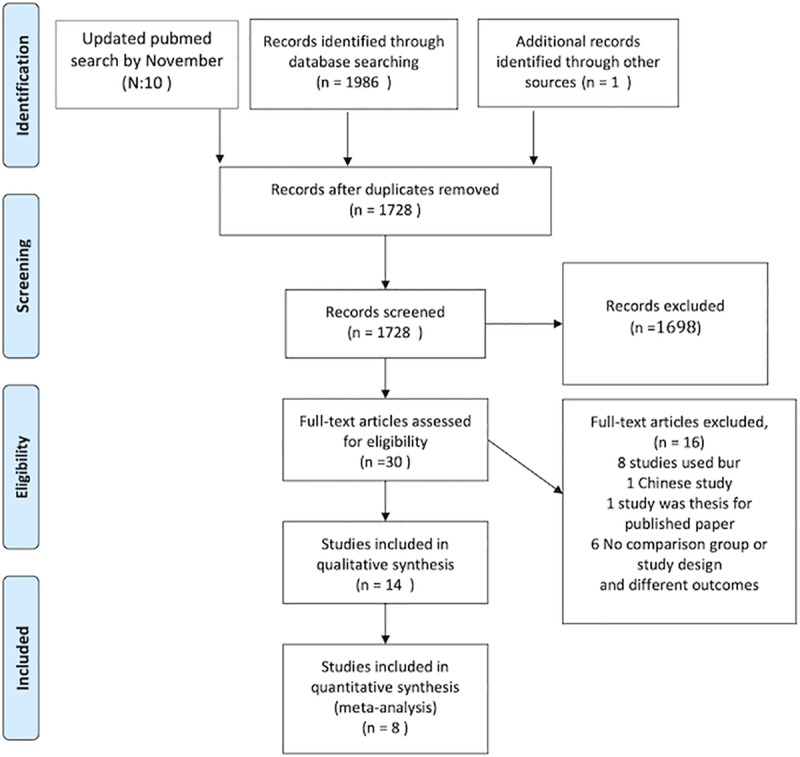
Flow diagram for included articles.